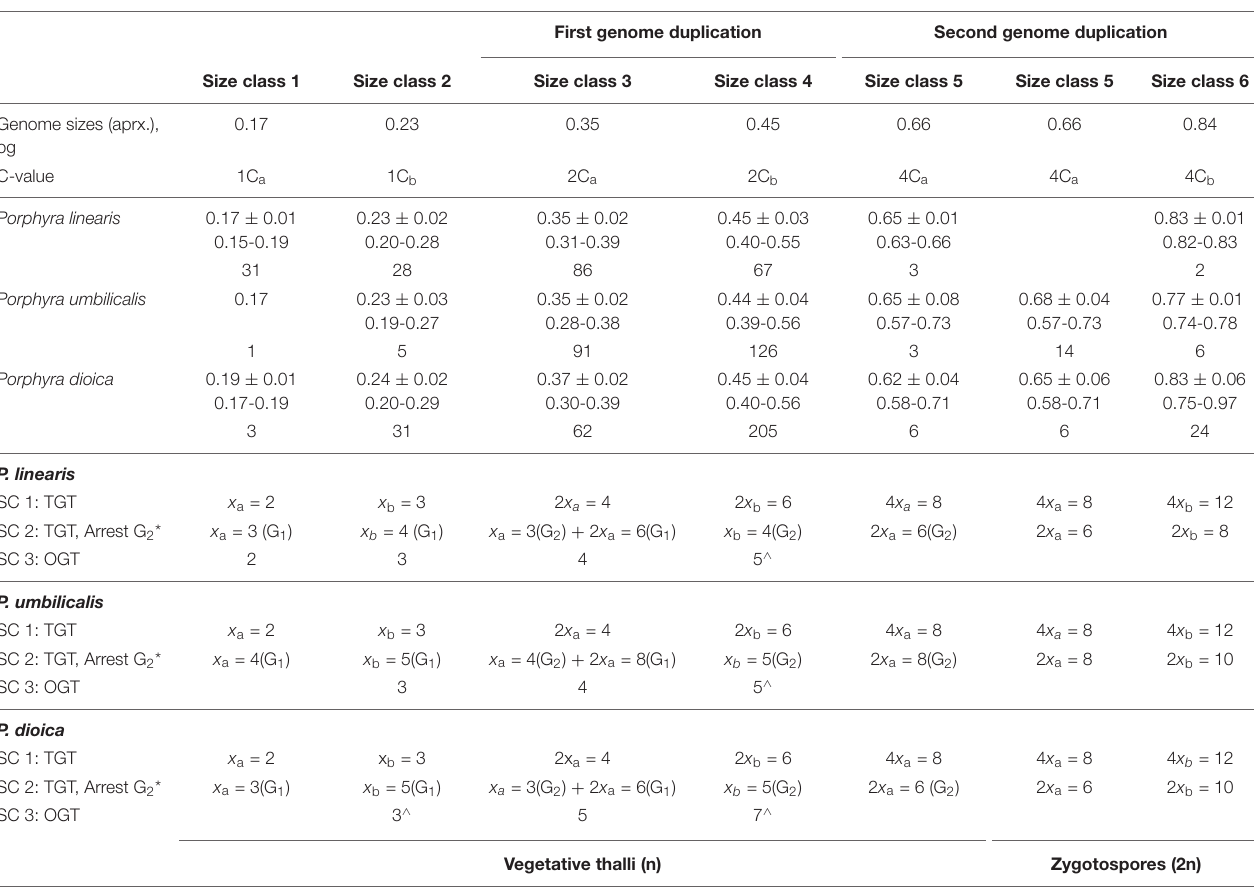
TABLE 2 | Genome sizes in vegetative thalli and zygotospores of Porphyra